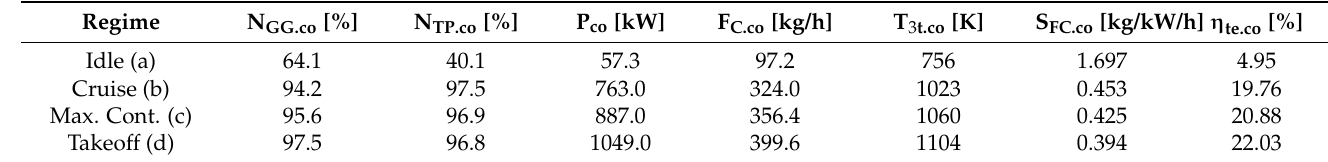
Table 9. TV2-117A operating regimes with corrected parameters.